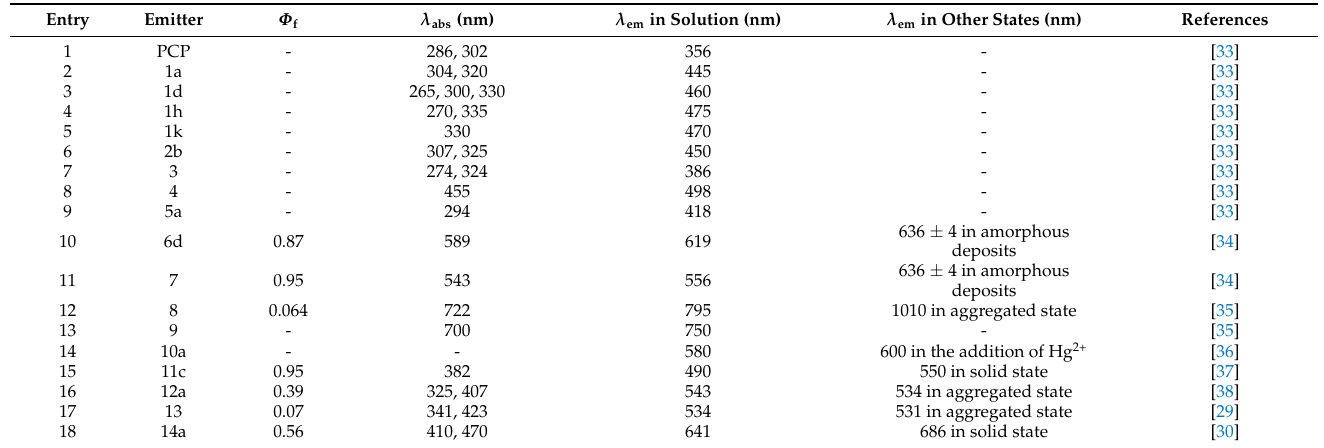
Table 1. Structures and spectroscopic properties of PCP-related fluorescent dyes 1 − 14.